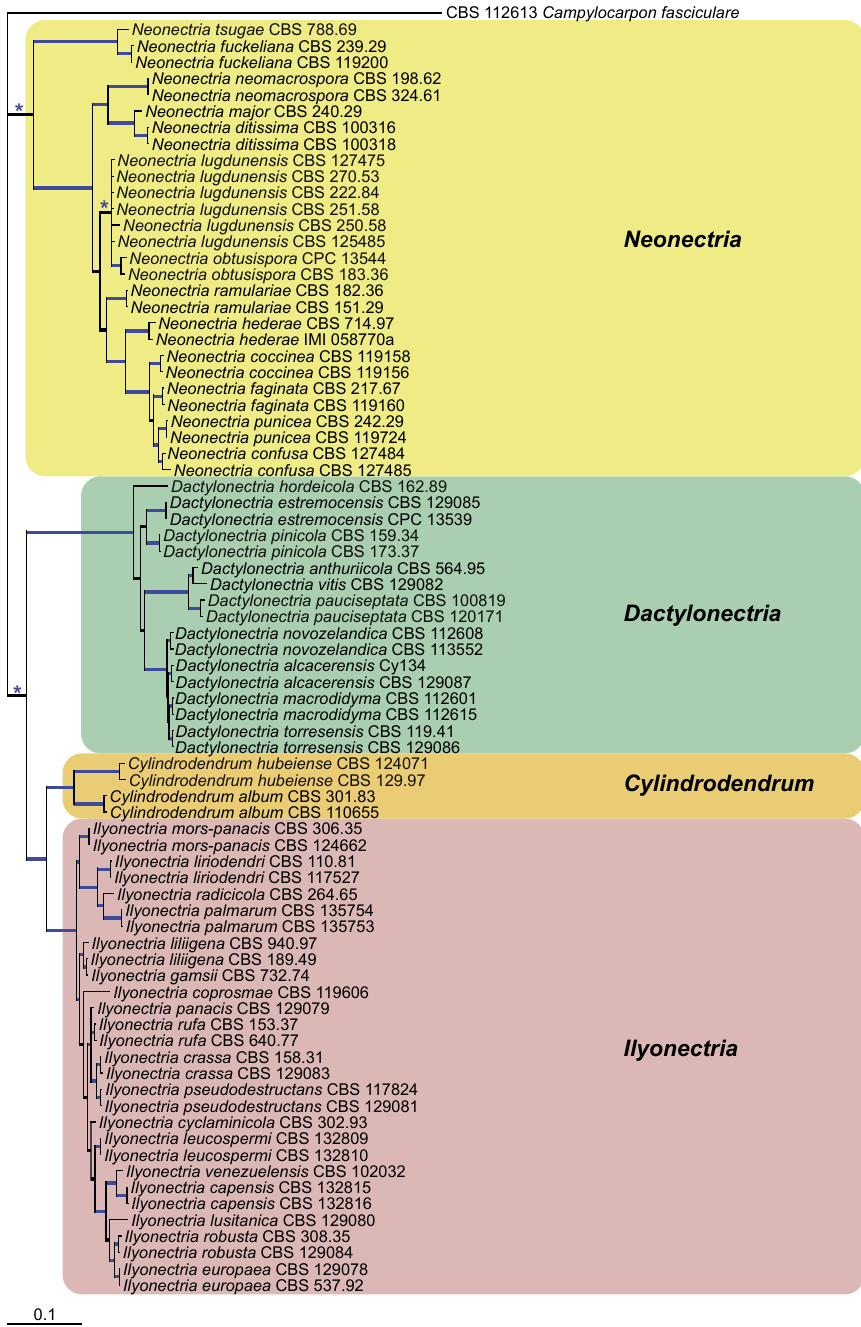
Figure 1. Consensus phylogram of 662 trees resulting from a Bayesian analysis of the combined four-gene sequence align- ment. Genera are indicated in coloured blocks. Thickened lines represents branches also present in the Maximum Likeli- hood (ML) and Maximum Parsimony (MP) consensus trees. Blue lines indicate Bayesian posterior probabilities (PP) ≥ 0.95 and bootstrap support (BS) values for both ML and MP ≥ 95% and blue stars indicate ML-BS and MP-BS ≥ 95% and PP < 0.95. The scale bar represents the expected number of changes per site. The tree was rooted to Campylocarpon fasciculare (CBS